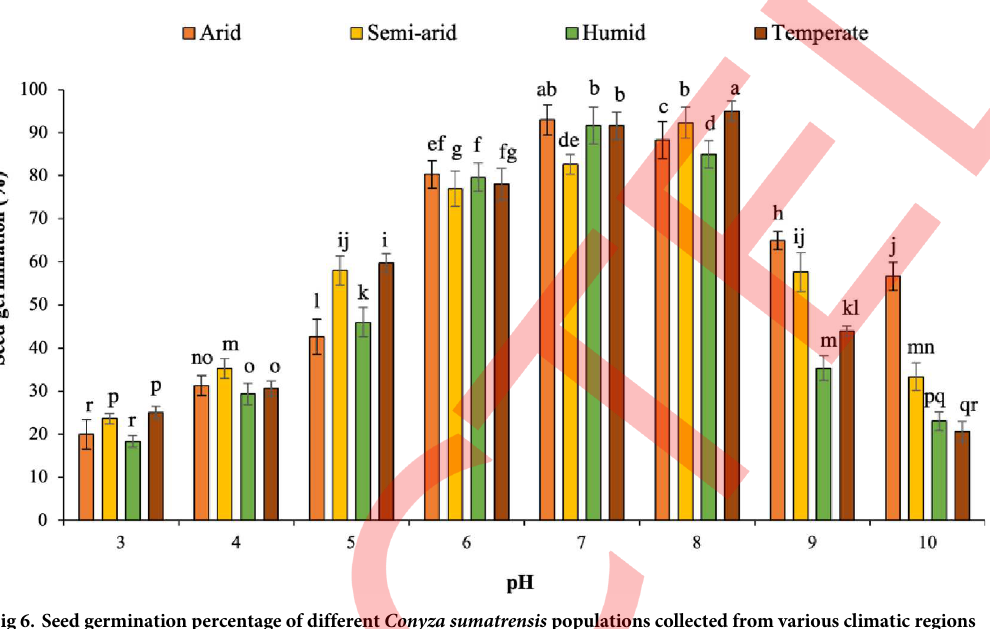
Fig 6. Seed germination percentage of different Conyza sumatrensis populations collected from various climatic regions under different pH levels.